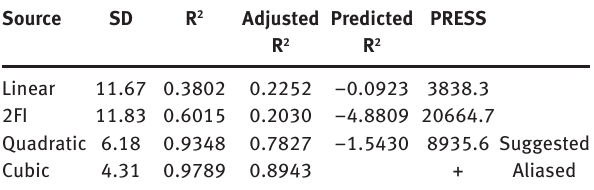
Table 3: Summary of model